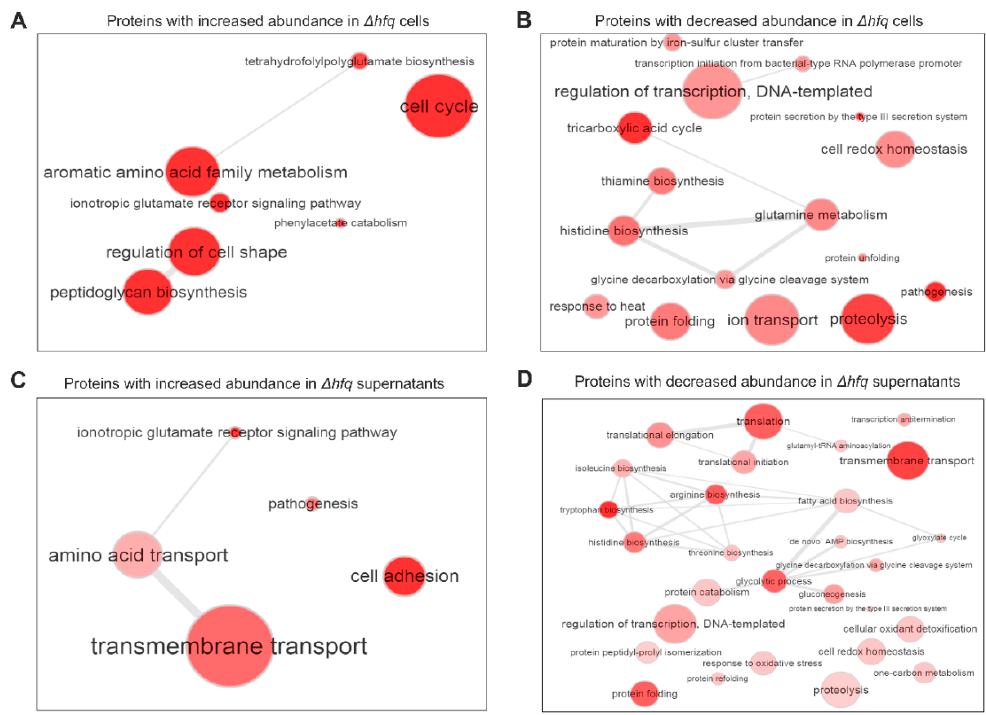
Figure 4. GO term enrichment analysis of genes either significantly upregulated ( A , C ) or downregulated ( B , D ) in the Δ hfq cells and Δ hfq culture supernatants, respectively. Biological processes significantly enriched for genes belonging to corresponding functional category are shown as an interactive graph. Significantly enriched terms from the domain “Biological processes” and their catenations are summarized and visualized by REVIGO. Circle size encodes number of genes associated with respective categories, red shades encode the significance level of the enrichment. Table 1. List of genes showing consistently increased RNA and protein abundance in the hfq mutant. Gene RNA-seq 1 Proteome 1 Secretome 1